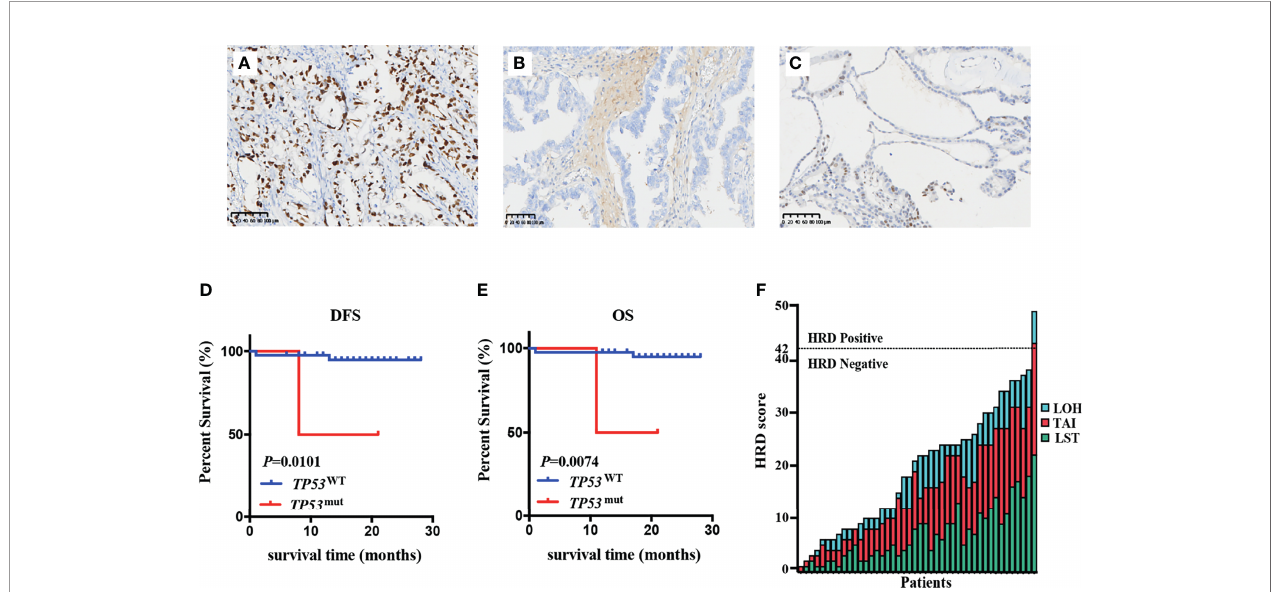
FIGURE 2 | Relationship between TP53 mutation status and patients ’ prognosis and HRD status in OCCC patients. (A – C) Immunohistochemistry was performed on tumors with TP53 mutation, showing intense and diffuse p53 immunostaining for likely pathogenic missense mutation (A) , completely absent p53 immunostaining for splicing mutation (B) , and rare p53-positive cells with VUS (C) . (D, E) Kaplan – Meier survival curves based on TP53 immunohistochemistry results. Patients with TP53 mutations had poor DFS ( p = 0.0101) (D) and OS ( p = 0.0074) (E) . p -values are calculated using the log-rank test. (F) HRD score in patients with OCCC. The columns and rows represent individual patient and HRD scores,